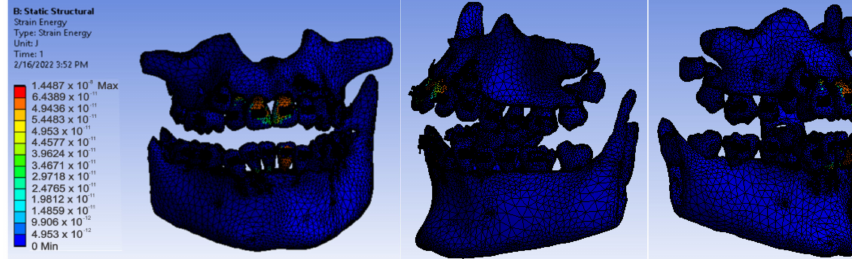
Figure 30. Stress maps.